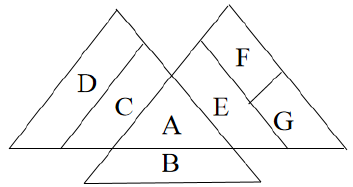
Figure 2. The relation among various transposition regular